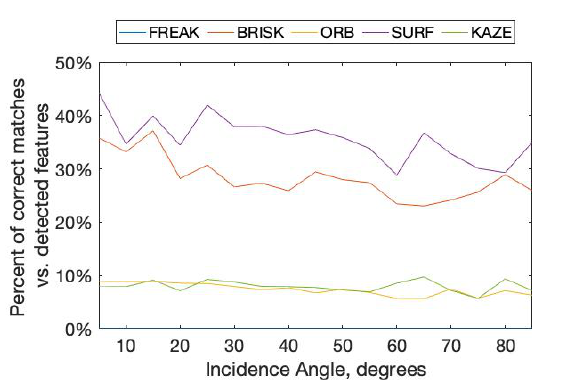
Figure 8. Performance of feature descriptors when the scale of the image was reduced by a factor of two.